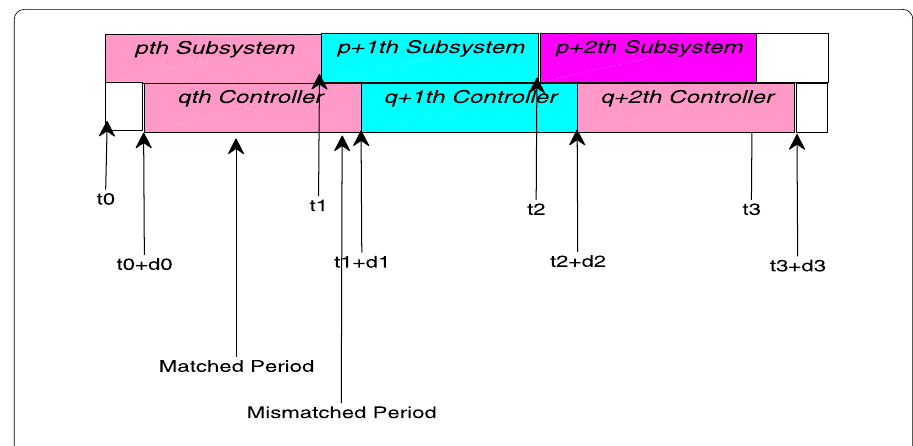
Figure 1 Asynchronous switching between subsystem and controller